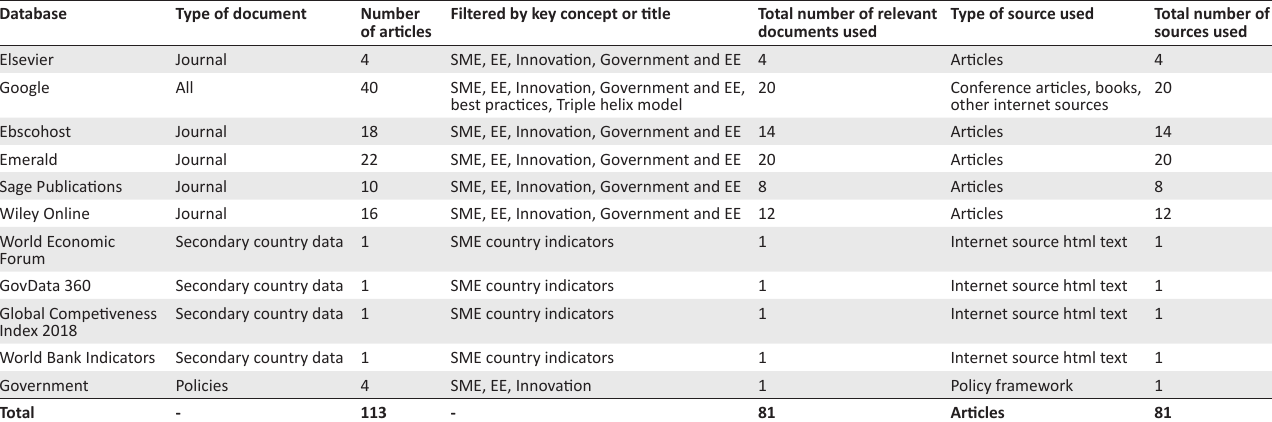
TABLE 1: Initial list of